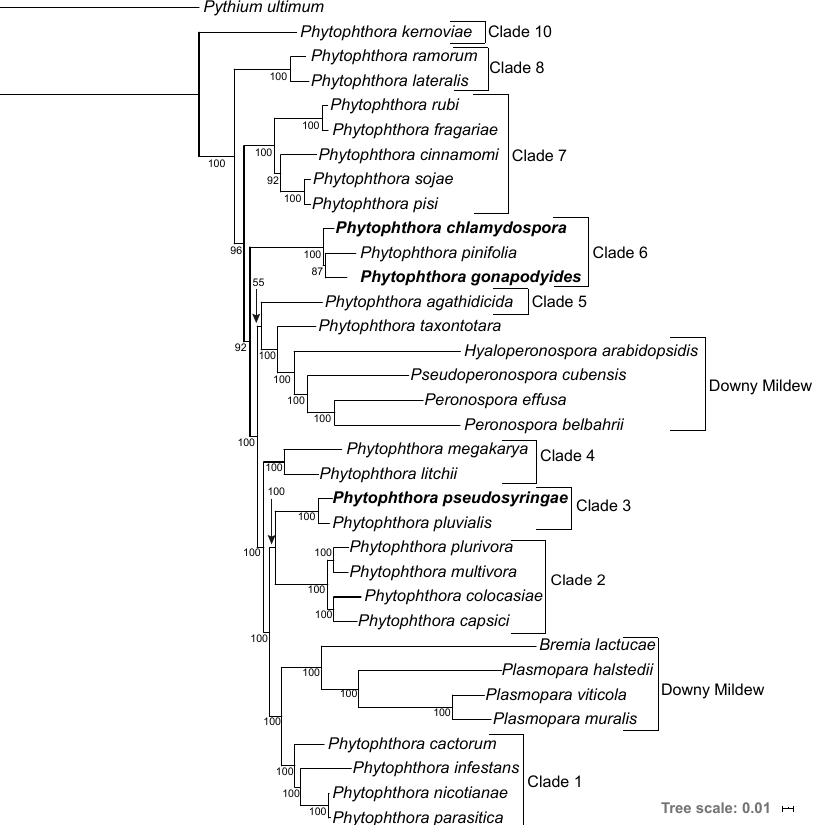
Figure 2. Supermatrix phylogeny of 33 Peronosporales species (208 BUSCO families, 106,315 amino acids). Py. ultimum is included as an outgroup. Phylogenomic analyses were performed using both maximum likelihood (IQ-TREE with JTT+F+R5 model) and Bayesian inference (Phylobayes MPI with the CAT model). Both methods inferred phylogenies with identical topologies. Branch lengths are shown. Maximum likelihood bootstrap supports are indicated at all nodes. Bayesian posterior probabilities were 100 for all nodes and are not shown.